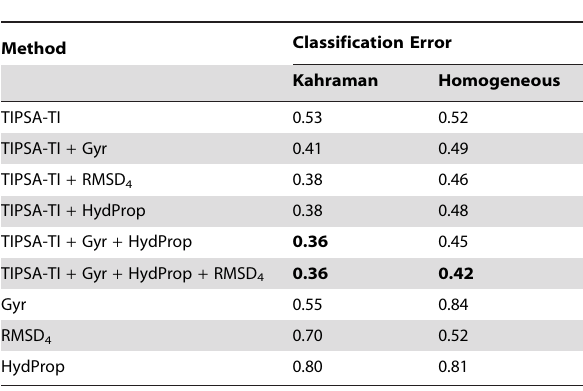
Table 8. Results of k -nearest neighbor classification for the Kahraman and Homogeneous data